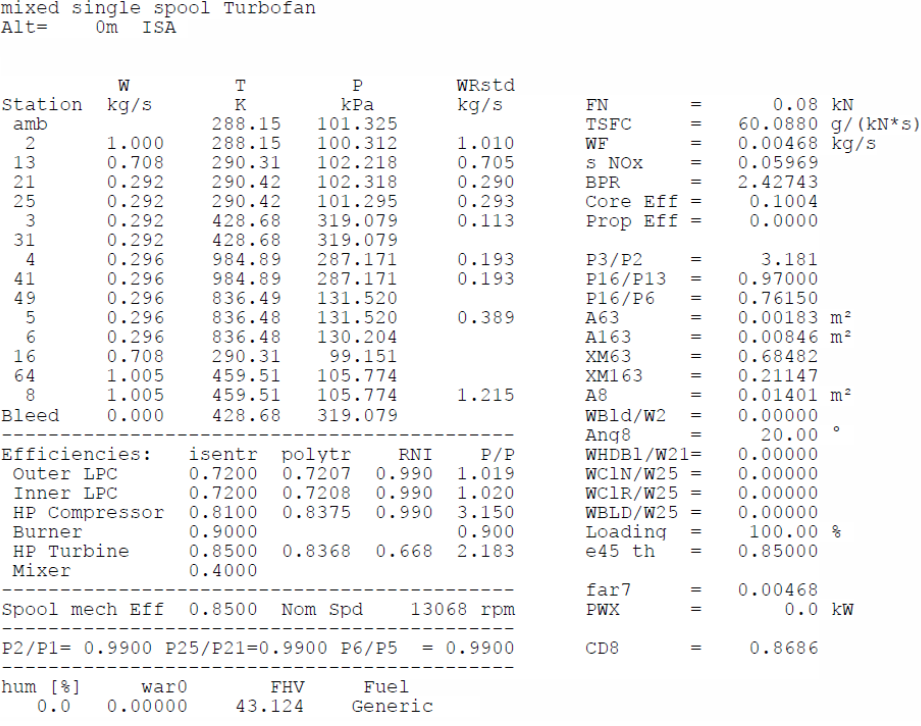
Figure A10. GasTurb simulation results for fan speed 13,068 RPM.